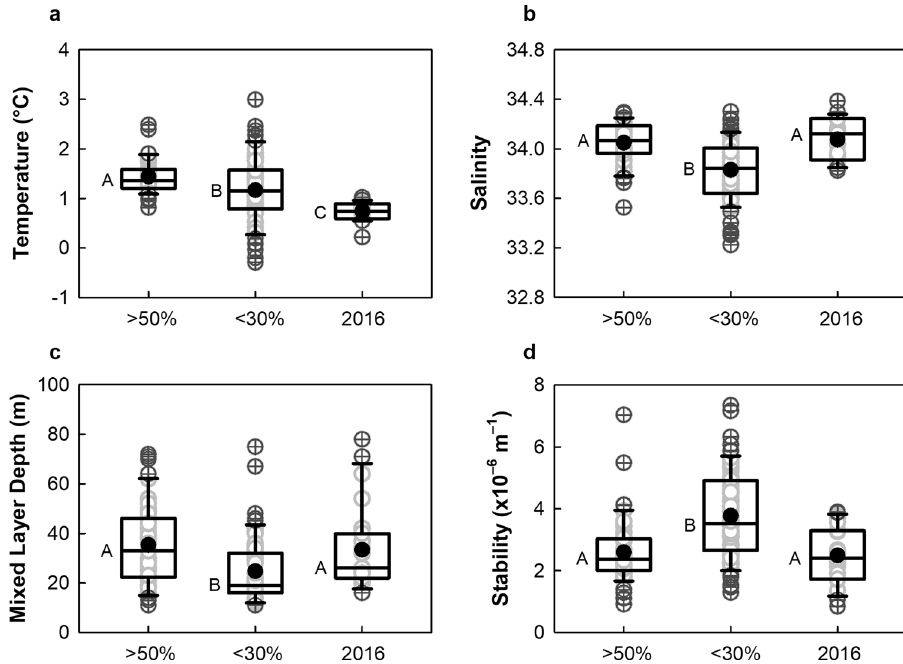
Fig. 4 Differences on water physical parameters between diatom proportions in the NAP late summer. a – d Box plots of surface temperature ( a ), surface salinity ( b ), mixed layer depth (MLD; c ), and upper ocean stability ( d ) for >50% (time series: 2008 − 2015, 2017), <30% (time series: 2008 − 2015, 2017), and 2016 (>50%) regarding to diatom proportion to the total chlorophyll- a (Chl- a ; see “ Methods ” ). The horizontal lines of the boxes indicate the median and the 25th and 75th percentiles. The dark gray circles with crosses indicate the outliers, and the light gray open circles indicate the individual values. Average values are presented by black closed circles. The whiskers extend to values not considered as outliers. Kruskal − Wallis tests were applied to determine the difference among groups (see “ Methods ” ) ( a : H 2 = 39.0, p < 0.001; b : H 2 = 29.3, p < 0.001; c : H 2 = 16.2, p < 0.001; d : H 2 = 28.3, p < 0.001). The capital letters indicate statistical groupings, which statistically differ each other at p < 0.05, based on all pairwise multiple comparison procedures with Dunn ’ s Method. In ( a − d ), n = 48, 68, and 23 for >50%, <30%, and 2016,